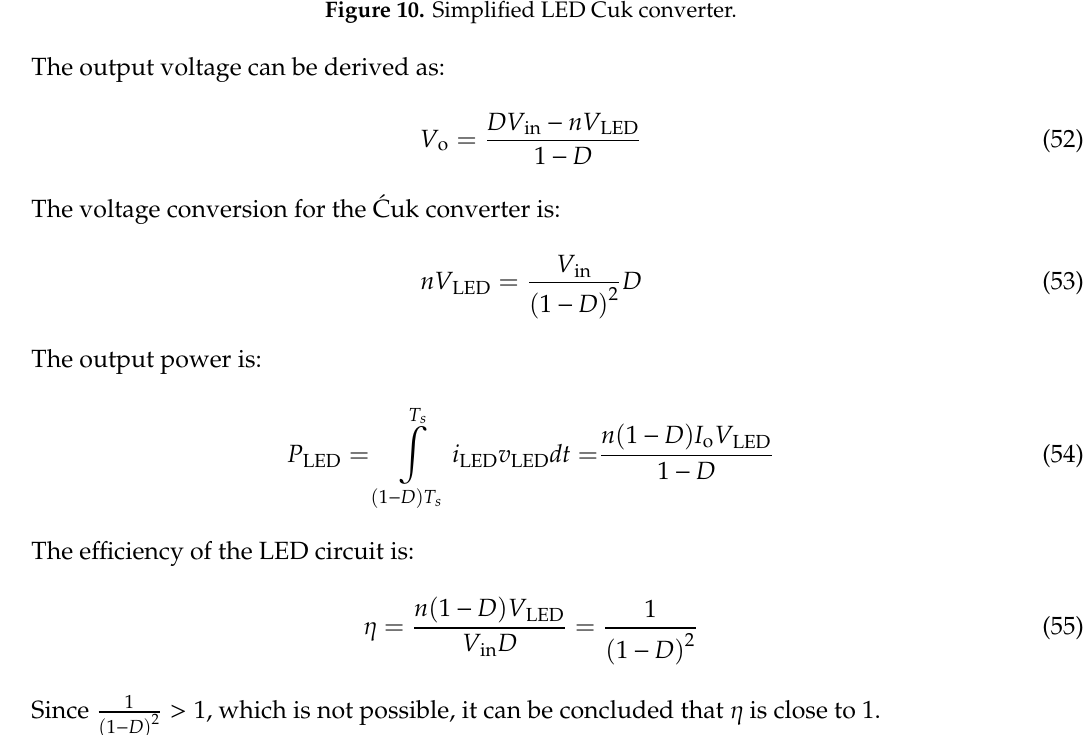
Figure 10. Simplified LED Ć uk converter.